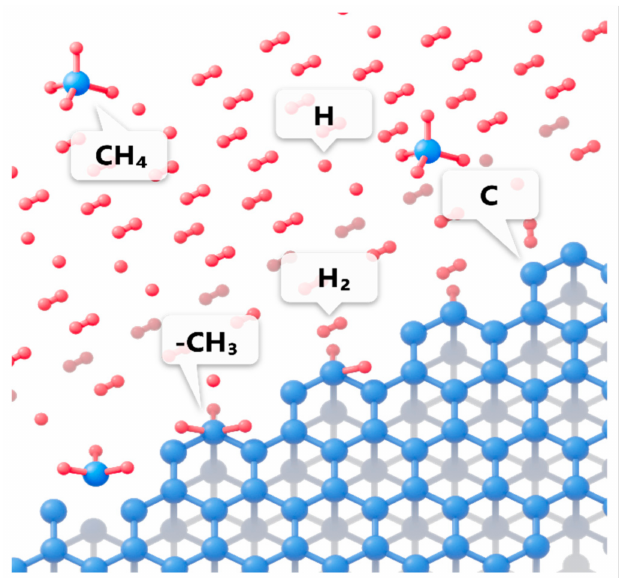
Figure 4. Diagram of M-CVD process: the dissipation of methane (CH 4 ) into methyl (-CH 3 ) and atomic hydrogen (H), the capture of a methyl group by the diamond cell, and further